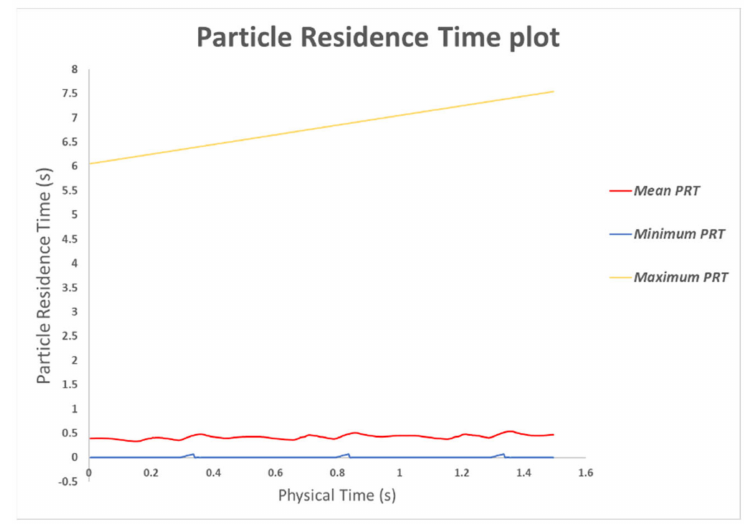
Figure 23. Average Particle Residence Time over three heart cycles.